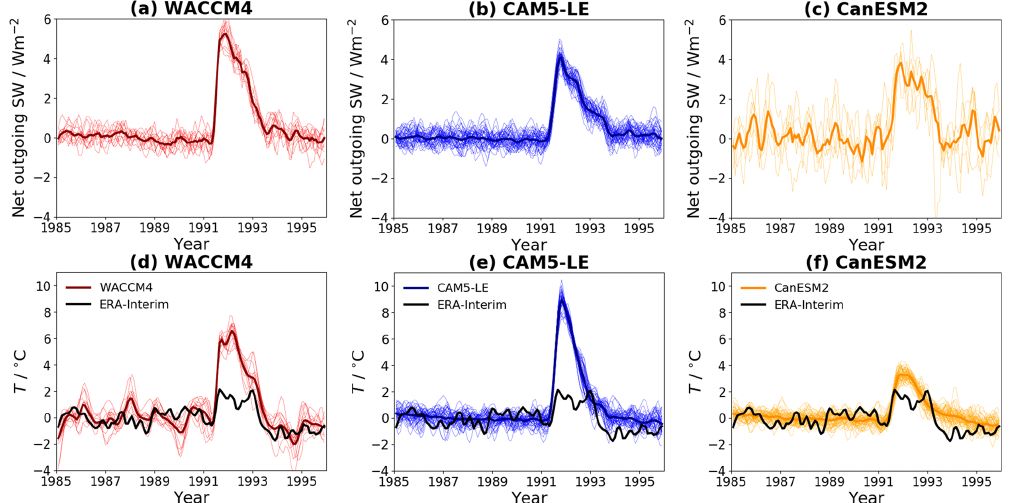
Figure 2. (a, b, c) Globally averaged, deseasonalized, net, outgoing SW radiation at the top of the atmosphere (Wm − 2 ). (d, e, f) Tropically averaged (30 ◦ S–30 ◦ N), deseasonalized temperature ( ◦ C) at 50hPa. (a, d) WACCM4 (red lines). (b, e) CAM5-LE-LE (blue lines). (c, f) CanESM2 (yellow lines). In each panel, the time series for each ensemble member (thin lines) and for the ensemble mean (bold line) are shown. In the bottom row, ERA-Interim values are also shown for comparison (black). All time series are anomalies from the 1985–1990 mean, and are smoothed with a 3-month running average, for direct comparison with Figs. 2 and 3 of Driscoll et al.